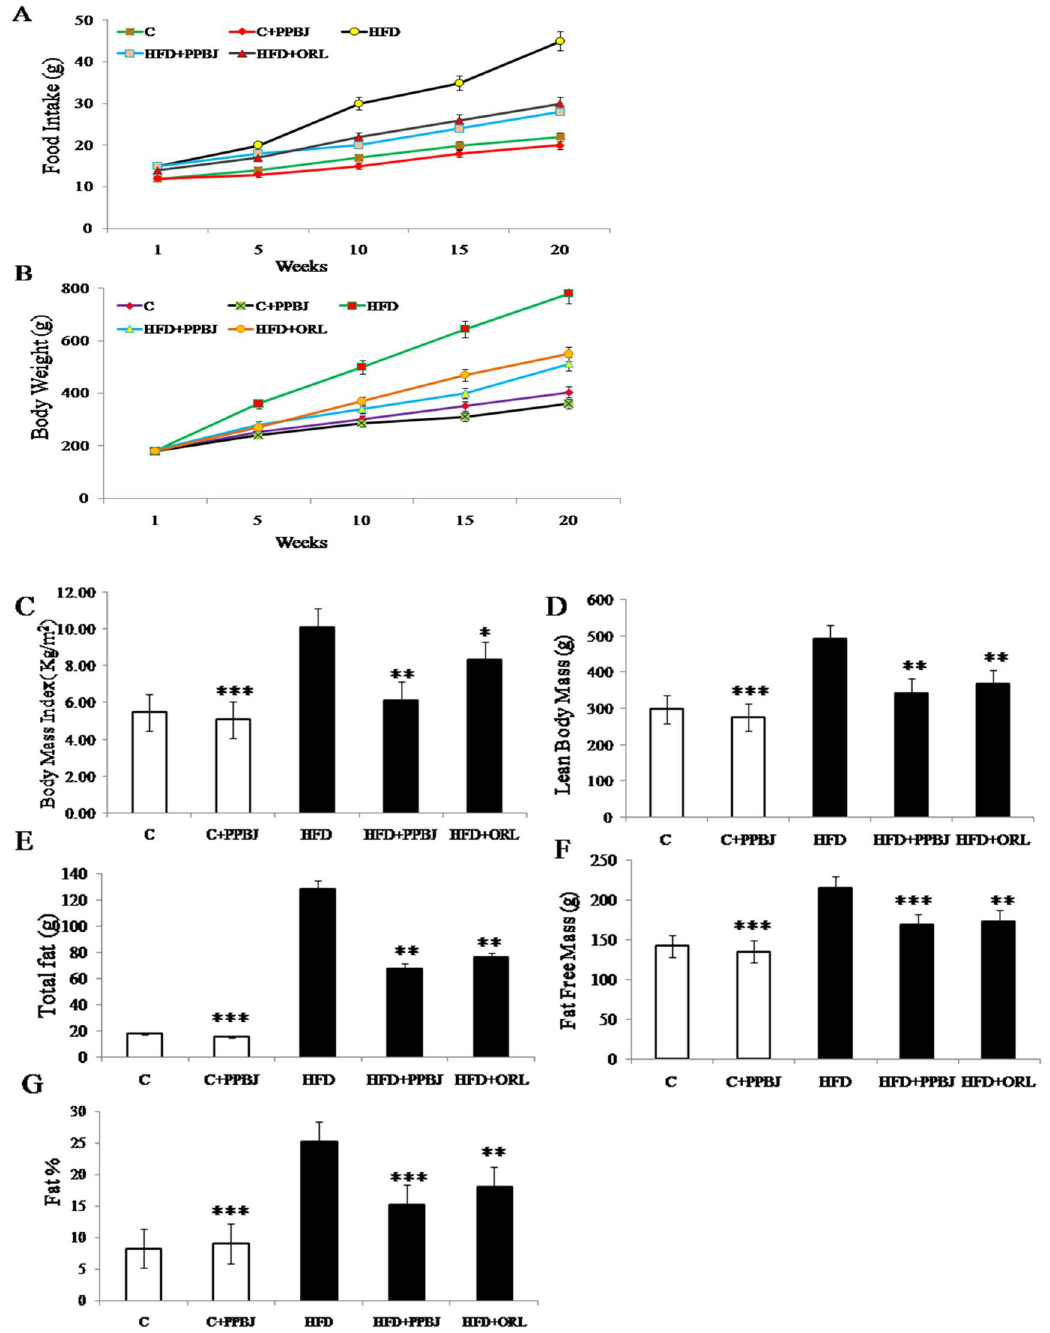
Figure 3. Effect of PPBJ on food intake, body weight and body composition in control and HFD induced obese rats for 20 weeks. ( A ) Food intake. ( B ) Body weights. ( C ) Body Mass Index. ( D ) Lean body mass. ( E ) Total fat. ( F ) Fat free mass and ( G ) Fat percentage. PPBJ pectinase treated probiotic banana juice; HFD high fat diet; ORL Orlistat. Data was presented as mean ± SEM (n = 6 each group). Statistically significance compared to their respective controls ***p < 0.001; **p < 0.01; *p < 0.05 . Groups compared using one way